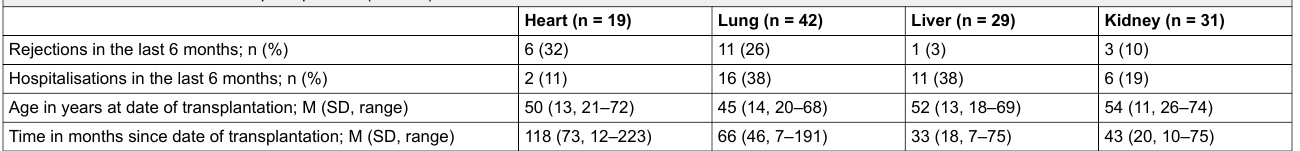
Table 2: Medical data of the transplant patients (n =